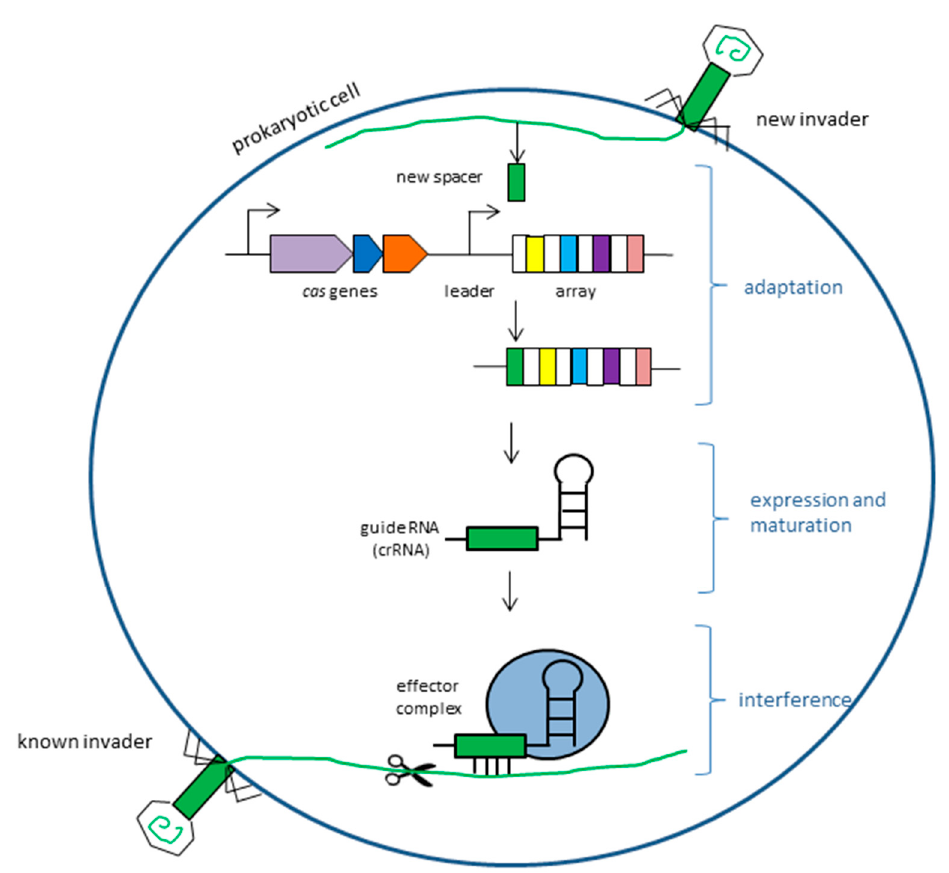
Figure 1. The three steps of CRISPR/Cas (clustered regularly interspaced short palindromic repeats/CRISPR-associated protein-9 nuclease) immunity.